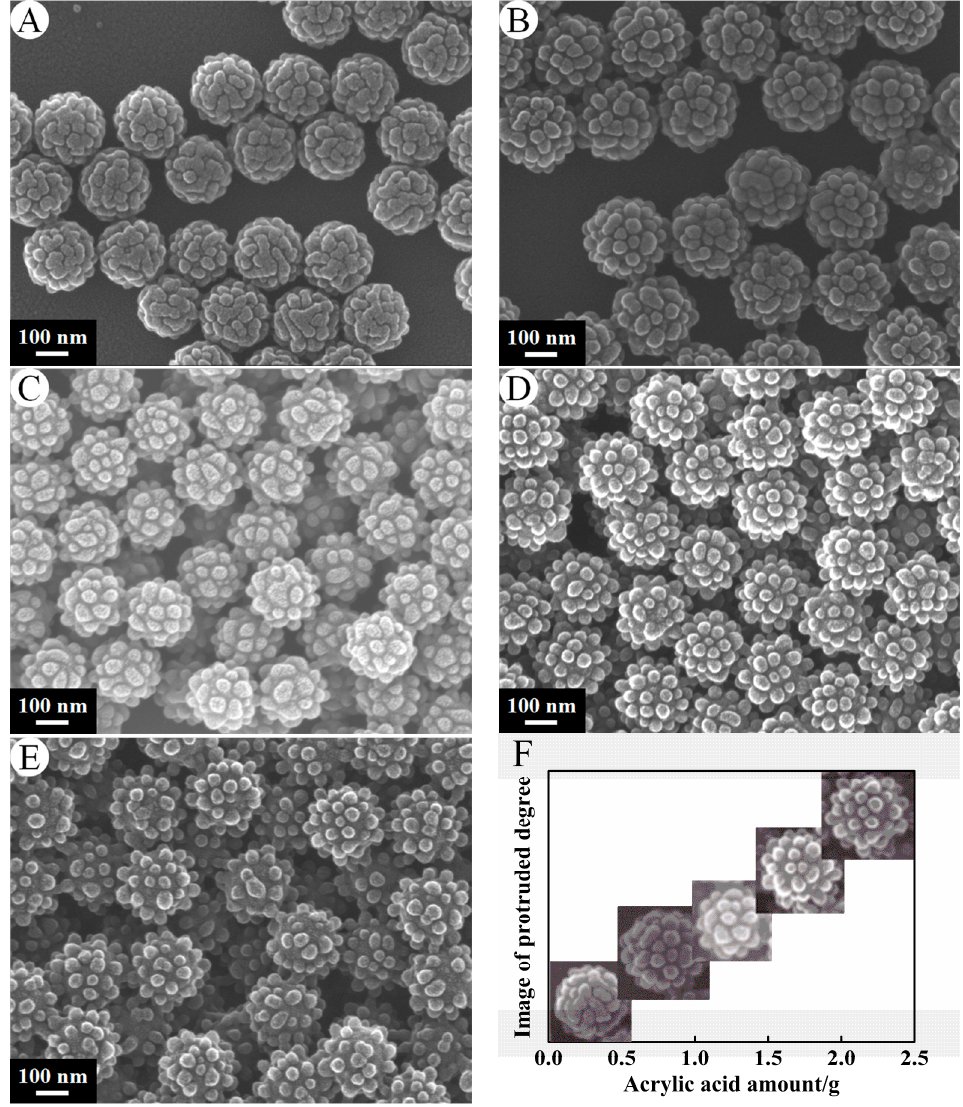
Figure 2. SEM micrographs of PSA nanospheres under preparation conditions of the acrylic acid (AA) amount ( A ) 0.6 g, ( B ) 1.2 g, ( C ) 1.5 g, ( D ) 1.8 g, ( E ) 2.1 g. Other conditions: St, 6 g; potassium persulfate (KPS), 0.12 g; stirrer speed, 300 r·min − 1 . Effects of AA content on the protruded degree of the PSA nanospheres ( F ).